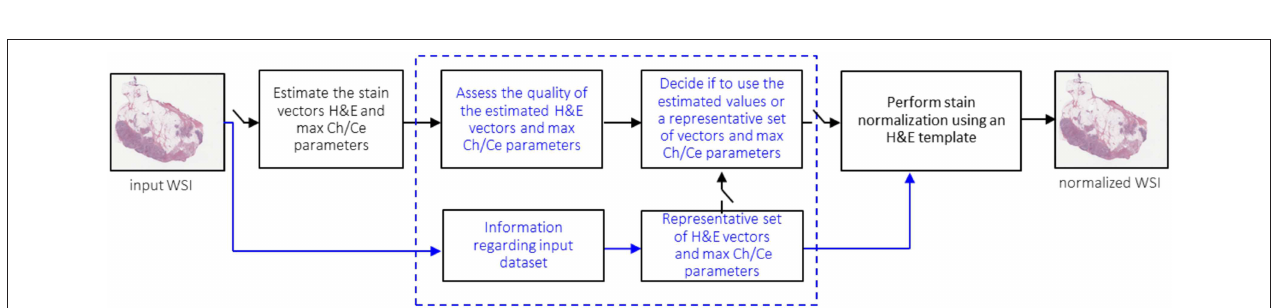
FIGURE 6 | First column (A,D) shows two original images from a prostate biopsy dataset. The second column (B,E) shows patches extracted from the original images, normalized using fast_sn . The third column (C,F) shows the same patches but normalized using fast_rsn.